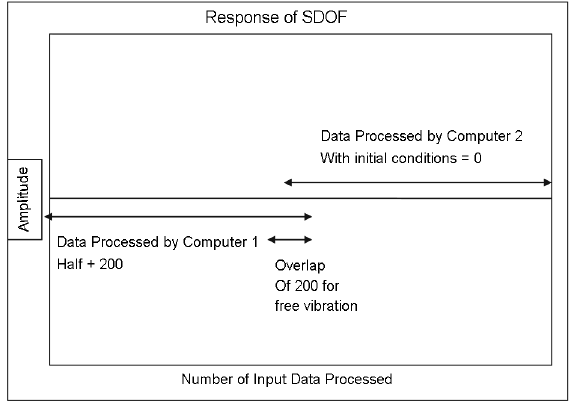
Fig. 3. Parallel framework for response of SDOF structure